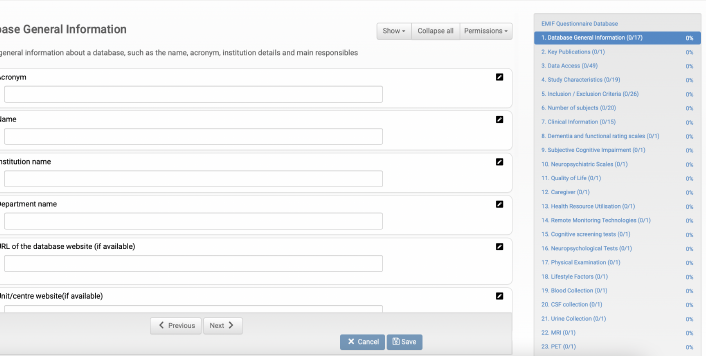
Figure 1. EMIF database questionnaire form to collect database characteristics. On the left, we have several fields to be filled in, and on the right, the different categories of data to be entered together with the current filling